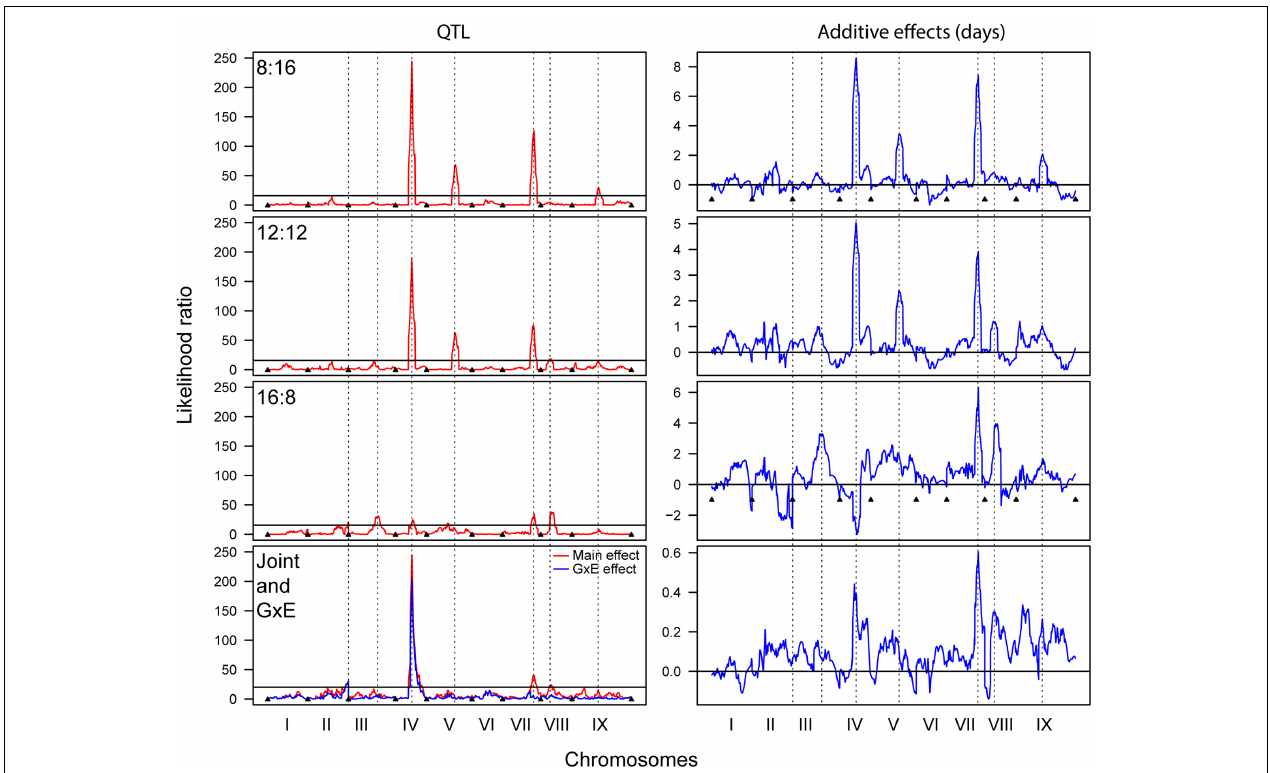
FIGURE 3 | Quantitative trait locus analysis for 8:16, 12:12, and 16:8 photoperiod trials, as well as for a joint analysis showing both main and GxE QTL (Left column), and the corresponding additive effects (Right column). Dashed lines denote significant QTL and indicate whether their positions correspond between